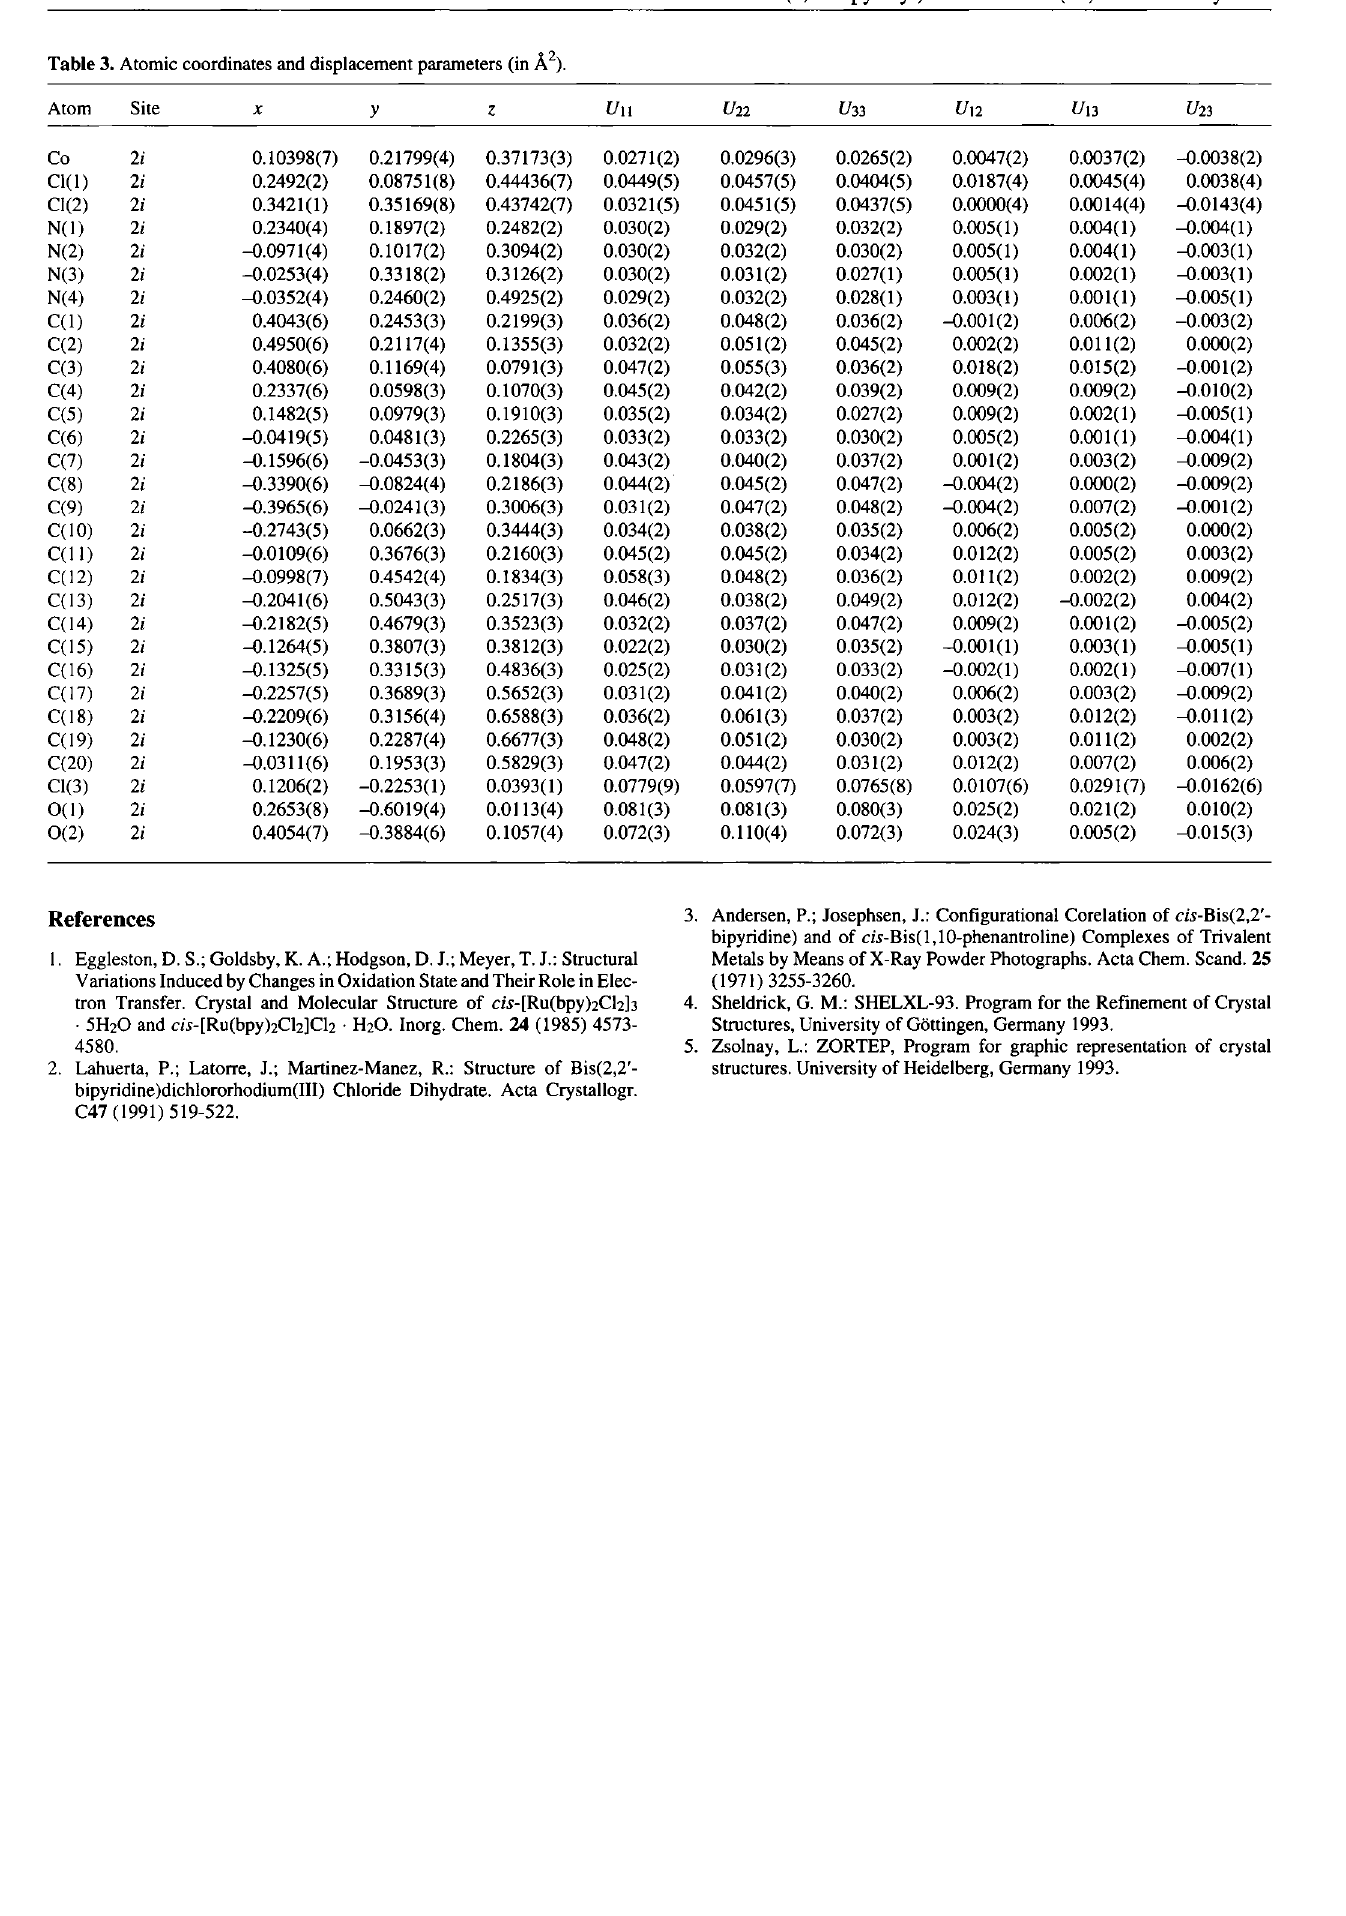
Table 3. Atomic coordinates and displacement parameters (in Â 2